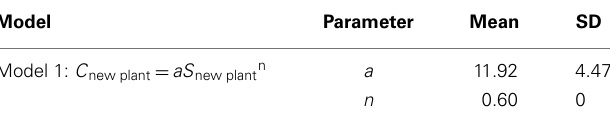
Table 4 |The input parameter for cost estimation using Model 1